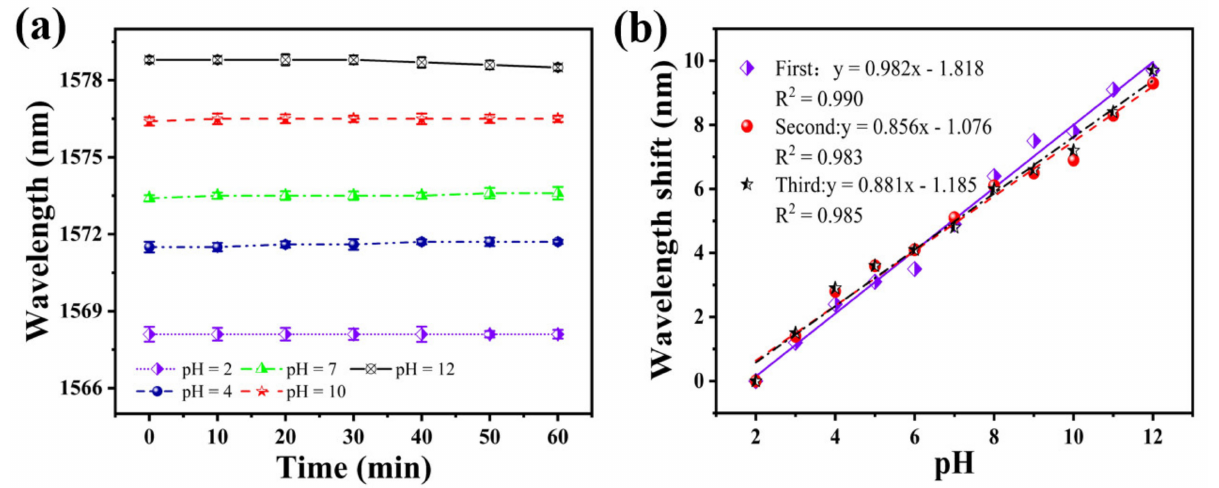
Figure 8. ( a ) Stability of the SNS sensor at different pH within 1 h; ( b ) shift of the resonance wavelength three pH tests on the same sensor, in the order of increasing